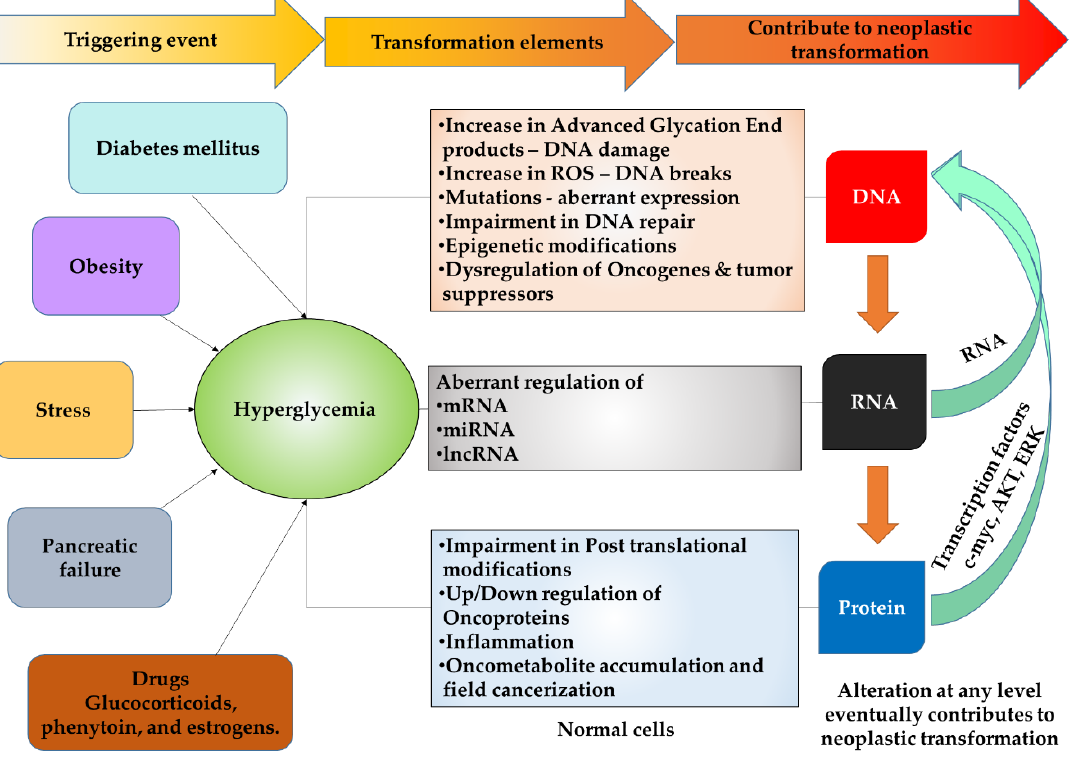
Figure 1. Hyperglycemia associated risk factors for cancer .